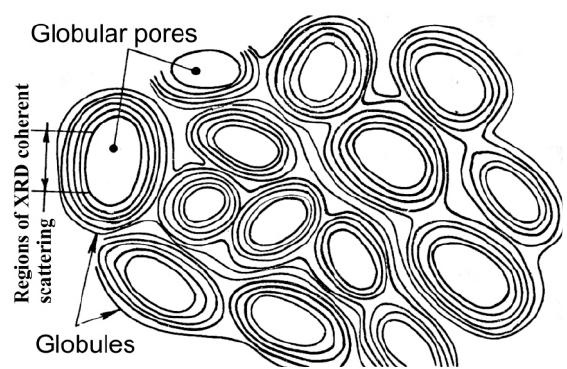
Figure 7. Physical model of shungite carbon. The figure is taken from [61].